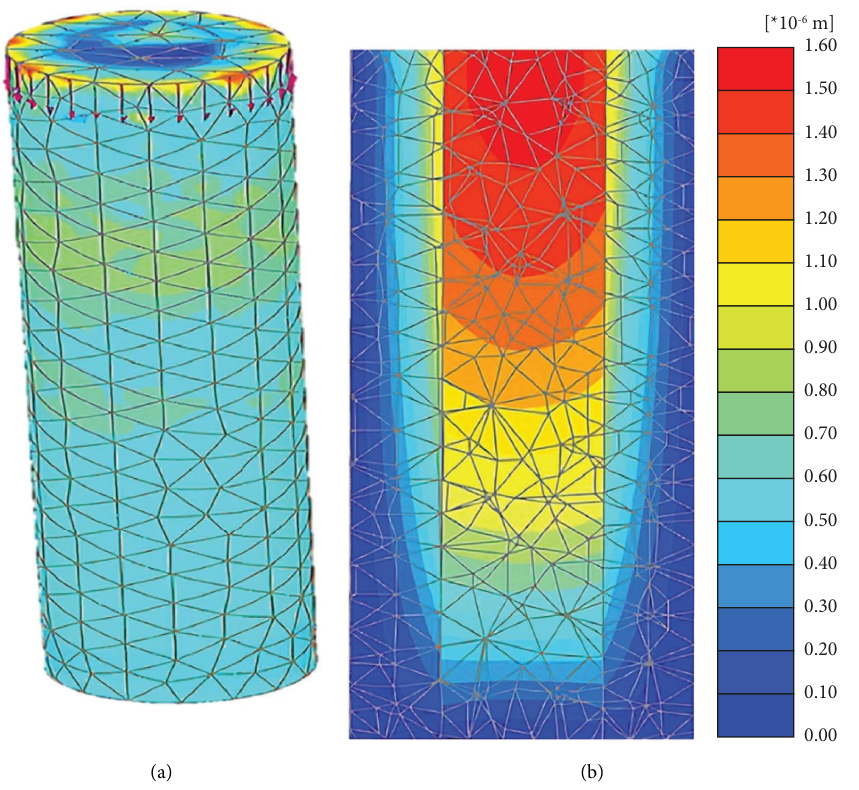
Figure 3: (a, b) Stone column with prescribed